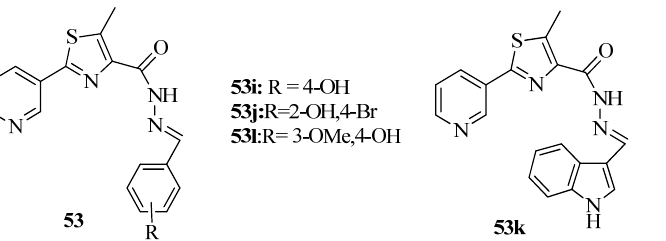
Figure 19. Structure of (E)-N’-substituted-5-methyl-2-(pyridin-3-yl)thiazole-4-carbohydrazides.